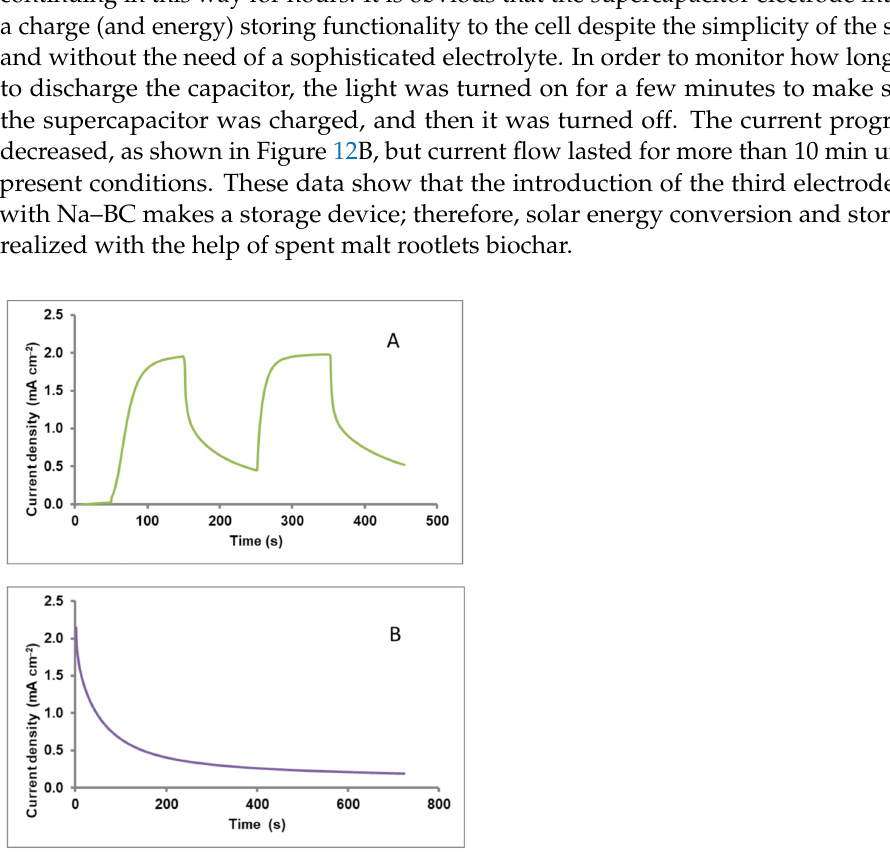
Figure 12. ( A ) Potentiostatic amperometry at V = 0 V by periodic light chopping for the cell with the supercapacitor electrode. ( B ) Same procedure at a different time scale. The starting point corresponds to a fully charged